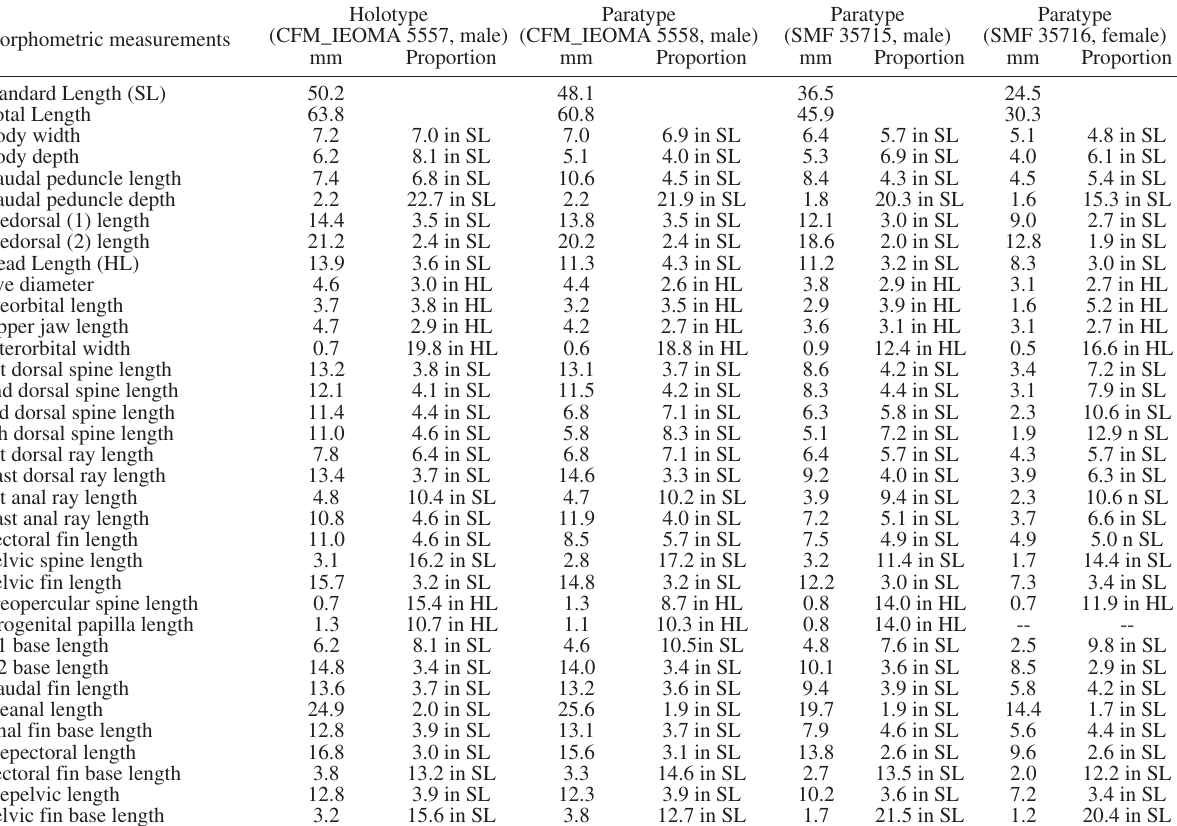
Table 1. – Morphometric measurements and proportions of the holotype and paratypes of Protogrammus alboranensis n. sp. SL, standard length; HL, head length. Morphometric